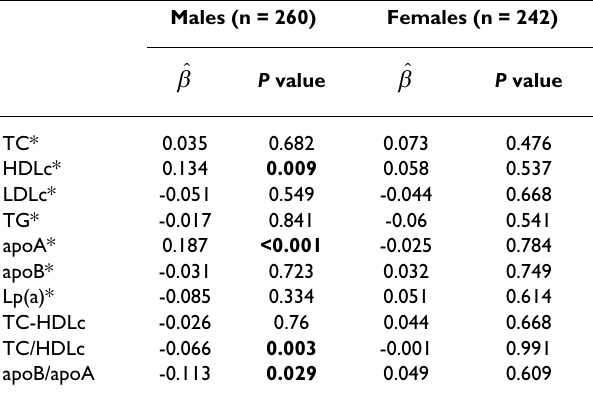
Table 2: Regression coefficients ( ) showing the association between birth weight score and blood lipid and lipoprotein levels by sex after controlling for age, pubertal stage, socioeconomic status, gestational age, body mass index and